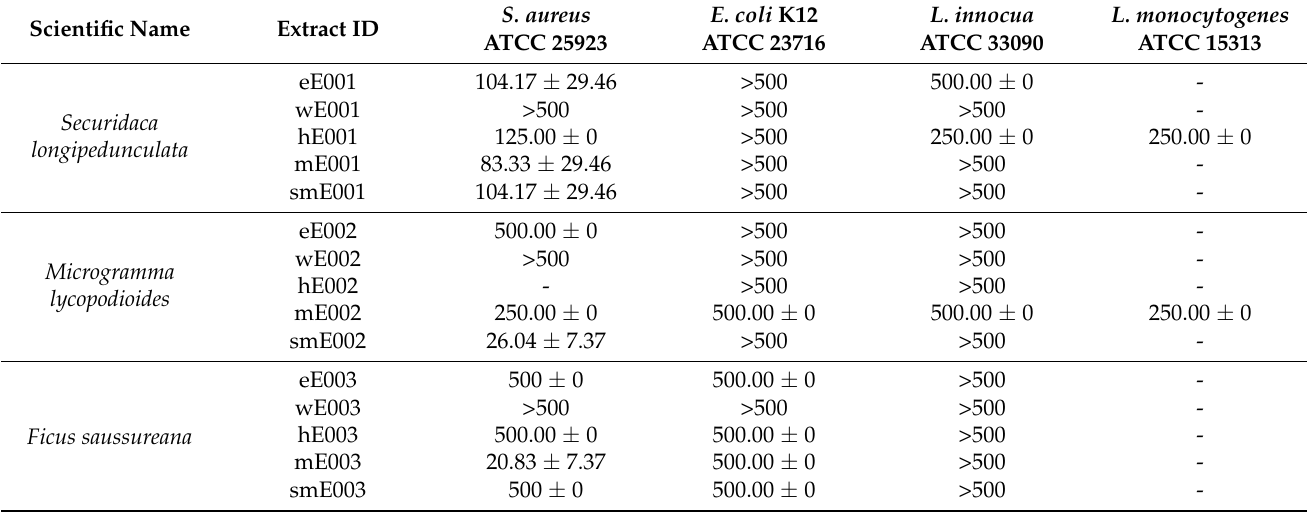
Table 3. Resazurin bioassay growth inhibition results of medicinal plants from the Greater Mpigi region; MIC values with standard deviations are expressed as concentration ( µ g/mL). The maximum concentration at which extracts were tested was 500 µ g/mL. Dashes indicate that a sample was not